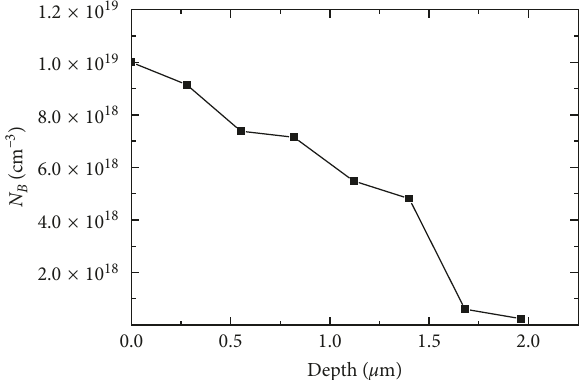
B crystal after diffusion at B in 4 H -SiC < >